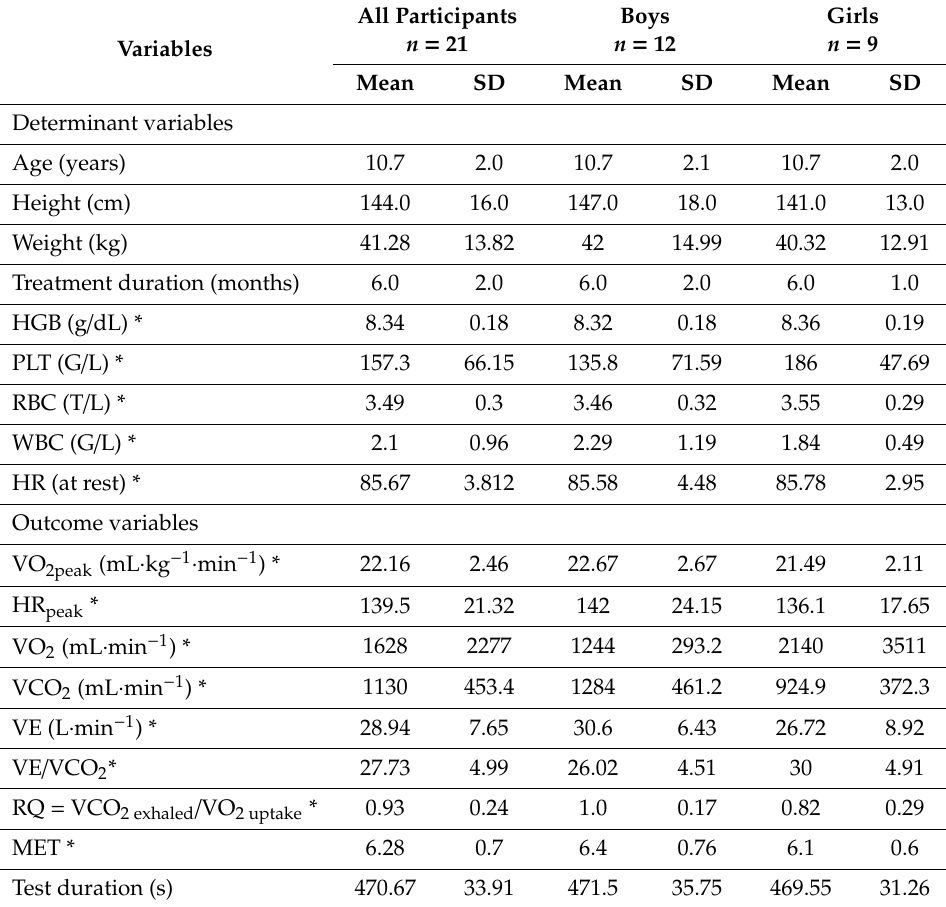
Table 1. Patient characteristics by